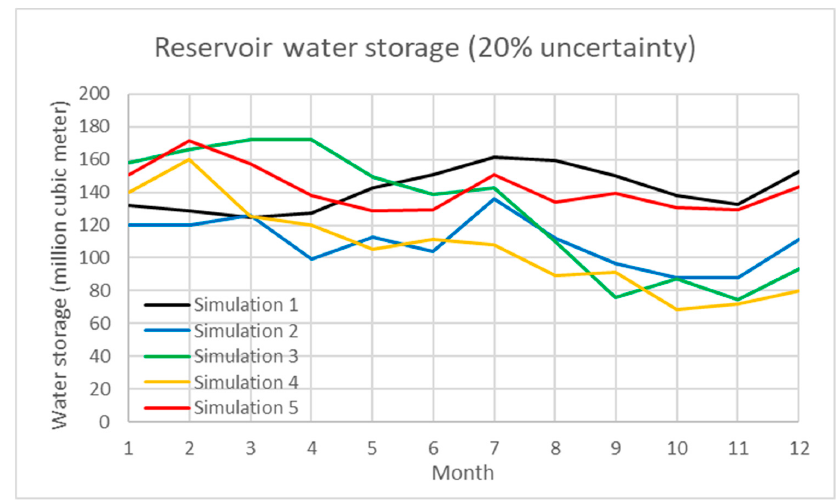
Figure 5. Simulation of water storage in the Shihmen Reservoir under 20% uncertainty of water inflow.